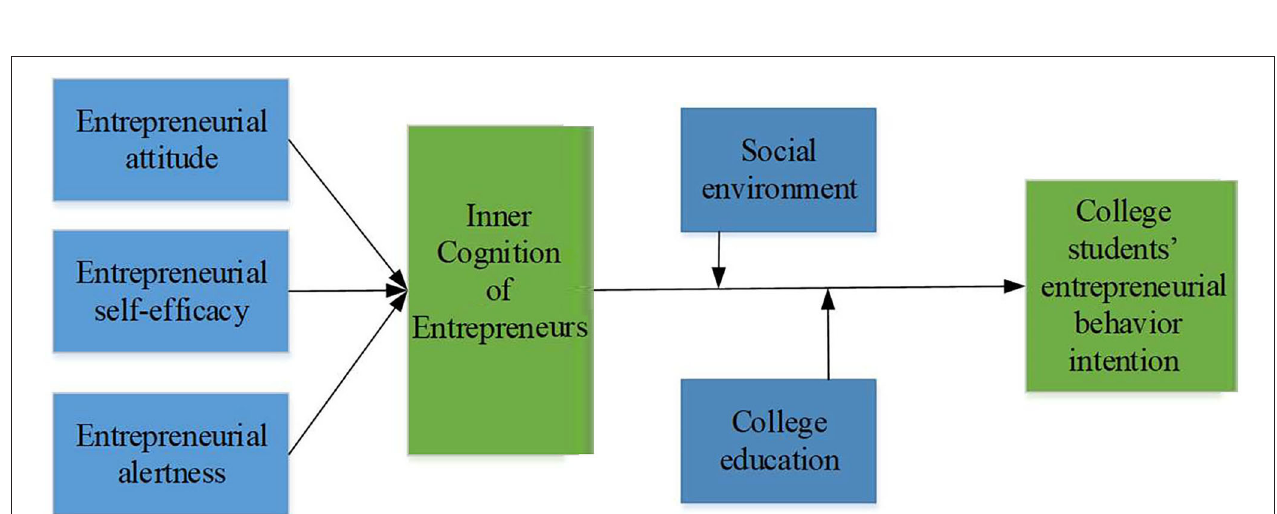
FIGURE 1 | Ternary interaction model.